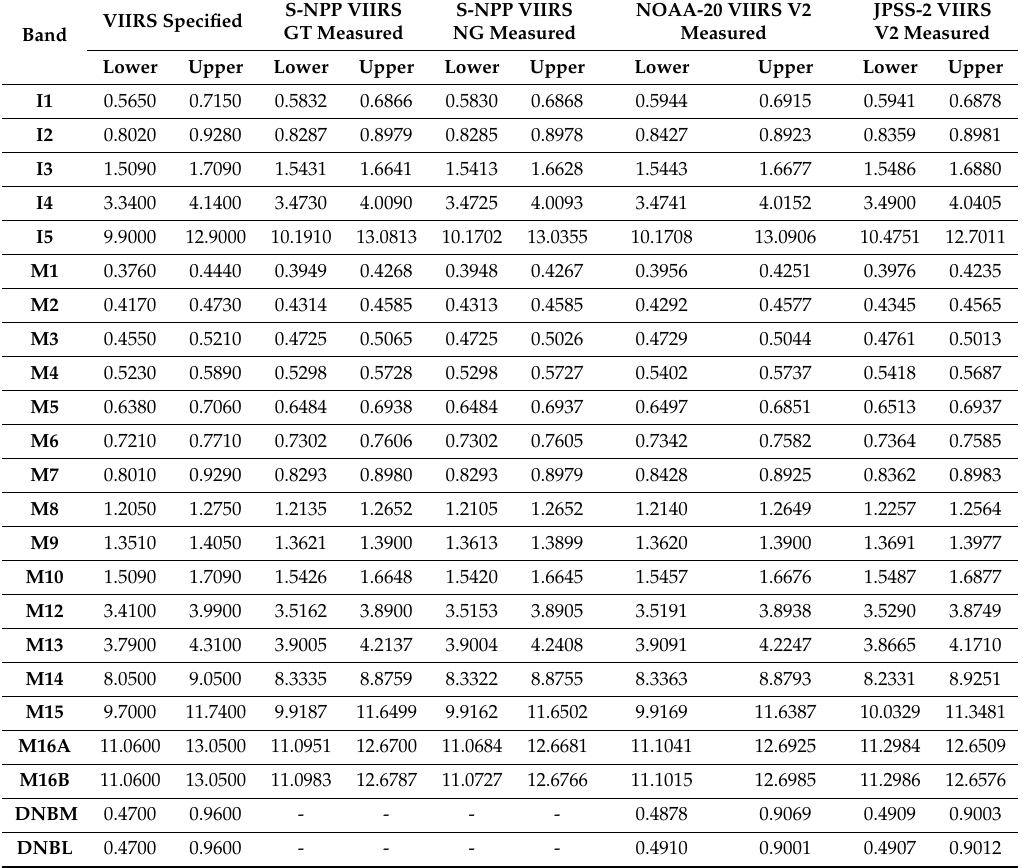
Table 1. Lower and upper 1% extended bandpass limits ( µ m) as provide by Moeller et al. [1,2,17,19].